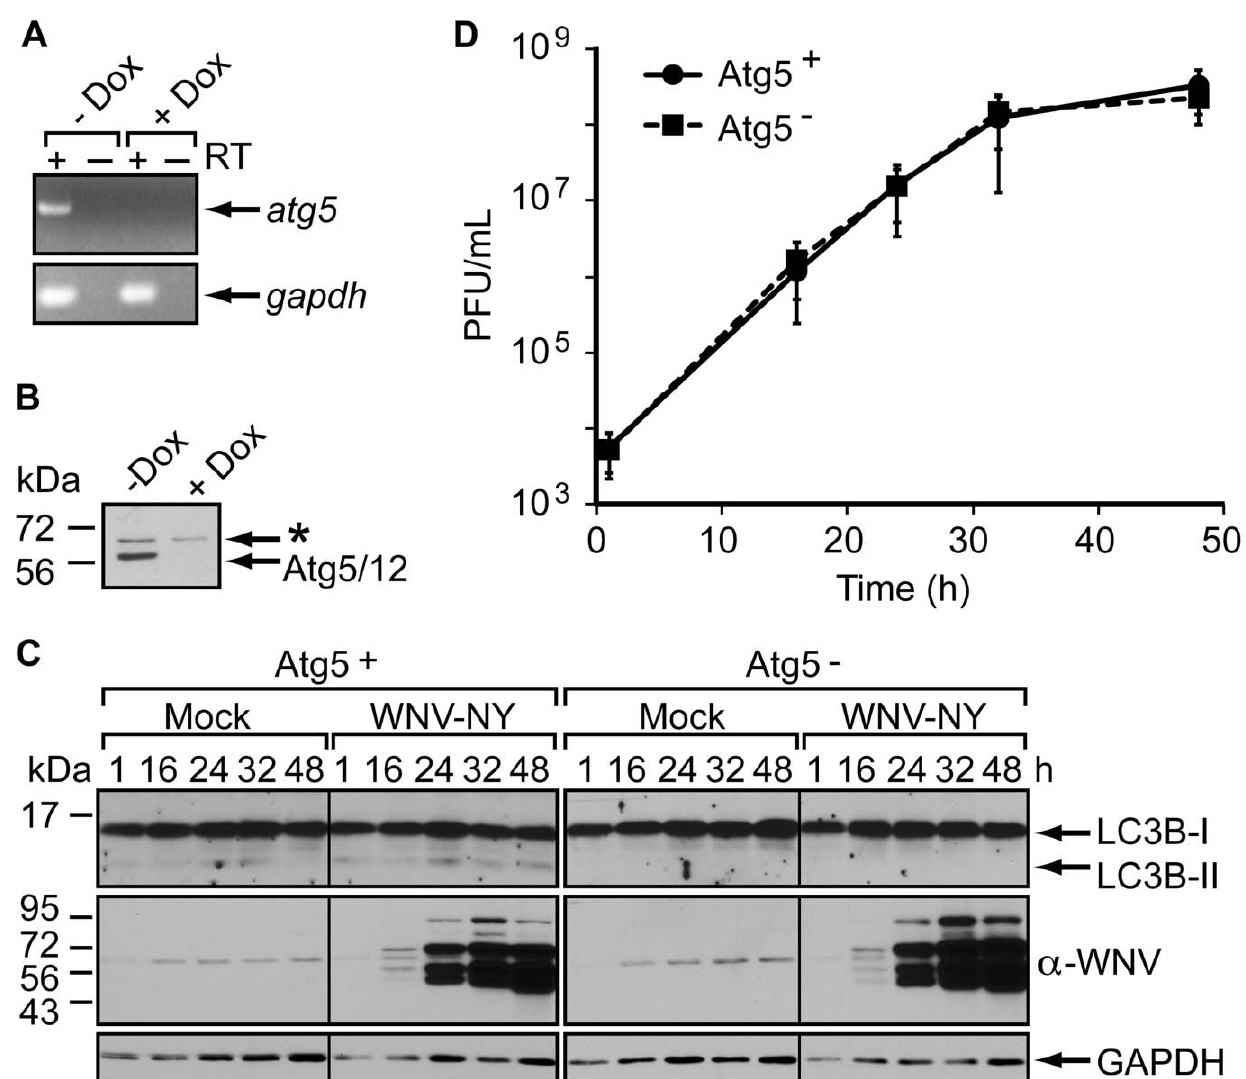
Figure 8. Atg5 is not required for WNV replication. (A) Atg5 mRNA in m5-7 cells. Standard RT-PCR ( + RT) was used to detect the presence of atg5 (top) or gapdh (bottom) mRNA in total RNA extracted from m5-7 cells grown in the presence or absence of 10 ng/mL doxycycline (Dox). PCR products were analyzed by agarose-gel electrophoresis. (B) Atg5 protein expression in m5-7 cells. Whole cell lysates prepared from m5-7 cells grown in the presence or absence of doxycycline were subjected to immunoblot analysis for Atg5 expression. A non-specific band (*) was also detected with this antiserum. (C) Immunoblot analysis of WNV-NY-infected m5-7 cells. m5-7 monolayers grown in the presence (Atg5 - ) or absence (Atg5 + ) of 10 ng/ mL doxycycline were mock-infected or infected with WNV-NY (MOI=3). After infection, inoculum was replaced with medium containing 10 m g/mL Peptastatin and E64d with or without 10 ng/mL doxycycline. Whole cell lysates were prepared at the indicated times (h) post-infection and subjected to immunoblot analysis for expression of LC3 (top), WNV (middle) and GAPDH (bottom). (D) WNV growth curves in the presence and absence of Atg5. Culture supernatants were recovered from the cells in Panel C at the indicated times (h) and the viral titers determined by plaque assay on Vero cells. Values represent the average ( 6 standard error) number of plaque-forming units (pfu) per mL from four independent